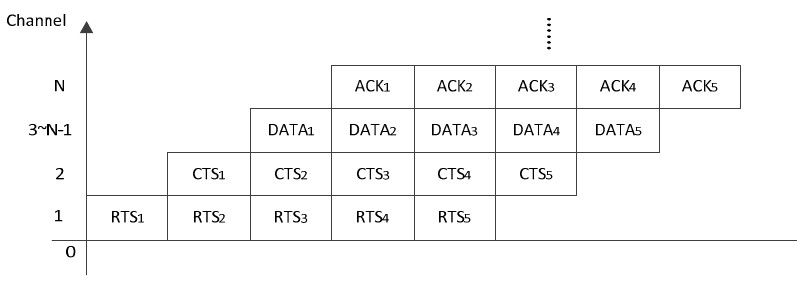
Figure 3. Implementing the typical transmission process with a four-stage pipeline.